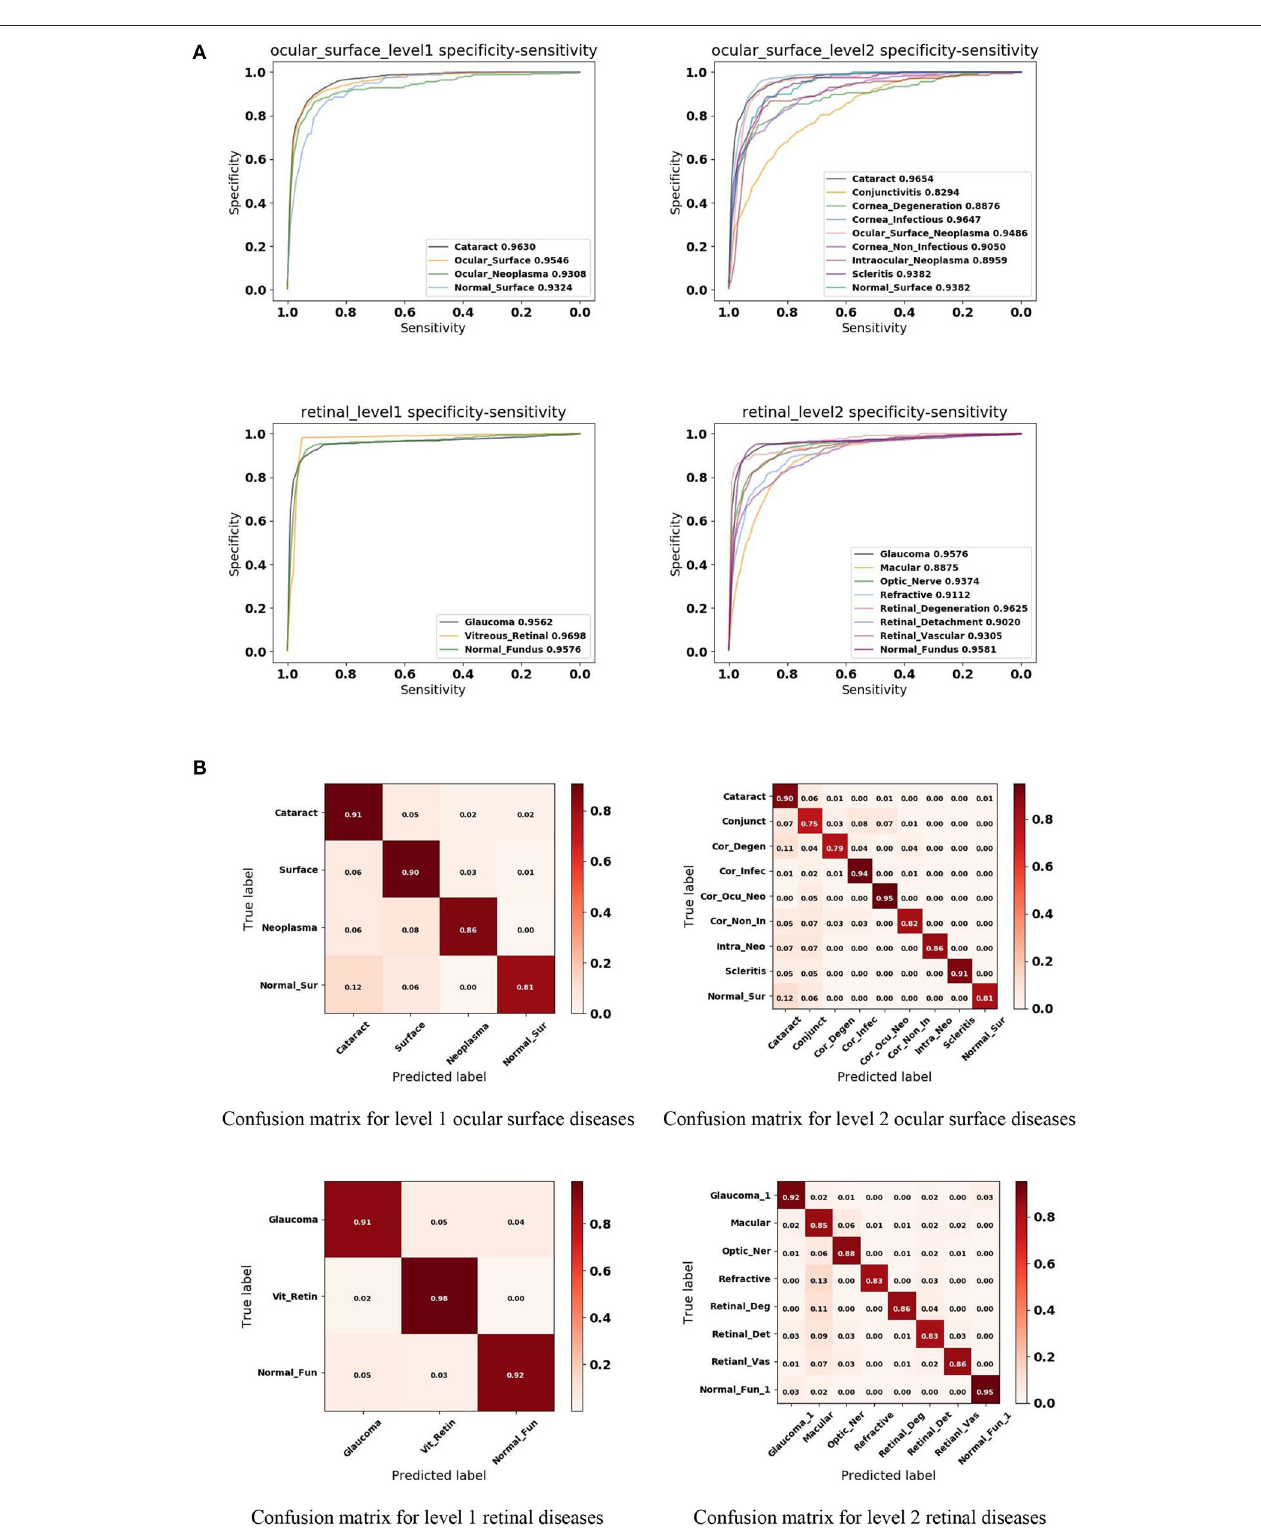
FIGURE 4 | Performance of the proposed hierarchical deep learning framework. (A) The mean receiver operating characteristic (ROC) curve for various eye diseases of the first two levels of the eye disease taxonomy. AUC is the area under the ROC curve. (B) Confusion matrices for the first two levels of the eye disease taxonomy. Conjunct, Conjunctivitis; Cor_Degen, Corneal_Degeneration; Cor_Infec, Corneal_Infectious; Ocu_Cor_Neo, Ocular_Corneal_Neoplasma; Cor_Non_In, Corneal_Non_Infectious; Intra_Neo, Intraocular_Neoplasma; Normal_Sur, Normal_Surface; Optic_Ner, Optic_Ner; Retinal_Deg, Retinal_Degeneration; Retinal_Det, Retinal_Detachment; Retinal_Vas, Retinal_Vascular; Normal_Fun, Normal_Fundus.